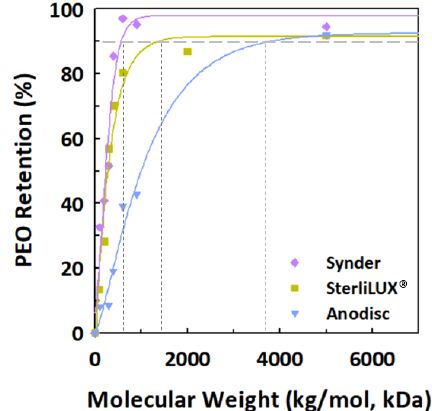
Figure 2. Cumulative distribution function for polyethylene oxide (PEO) solutions with a molecular weight (MW) of 100-5000 kg/mol (kDa) with the polymeric (Synder and SteriLUX ® ) and ceramic (Anodisc) membranes, and with an average pore size of 0.1 μm. Retention performance is based on measured total organic carbon (TOC) concentrations of the solutes.